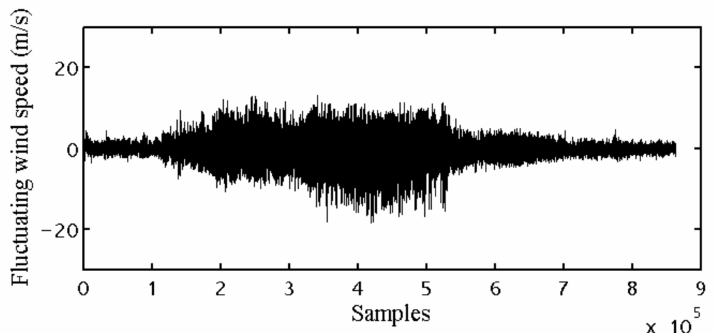
Figure 9. Fluctuating wind speed during Typhoon Maria.